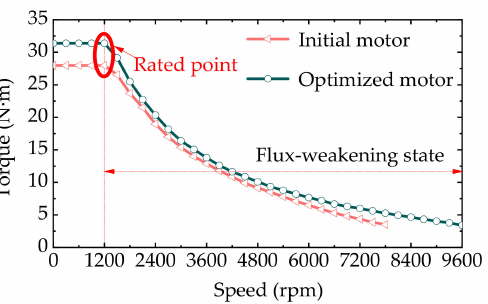
Figure 13. The torque-speed curves of the initial motor and the optimized motor.